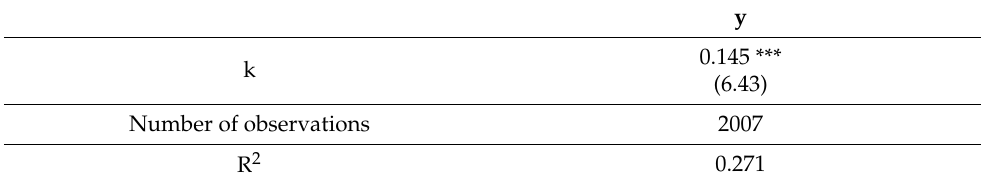
Table A2. Second stage TFP estimation—OP